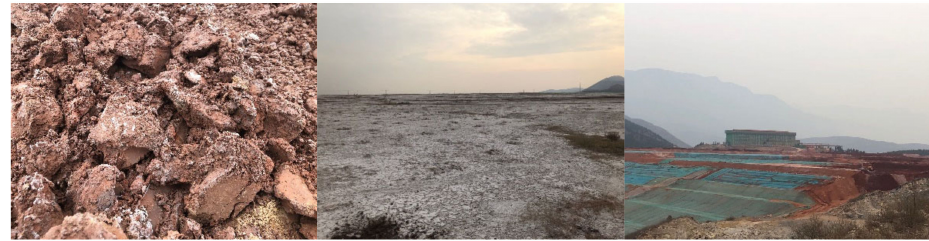
Figure 1. Open-air storage yard of red